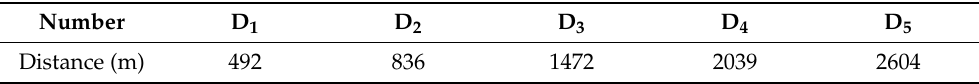
Table 2. Distance of each traffic light from the starting position.